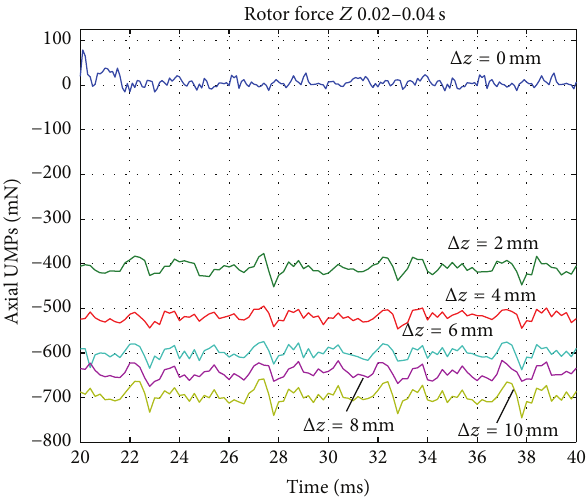
Figure10:AxialUMPwavesunderdifferenteccentricityconditions.